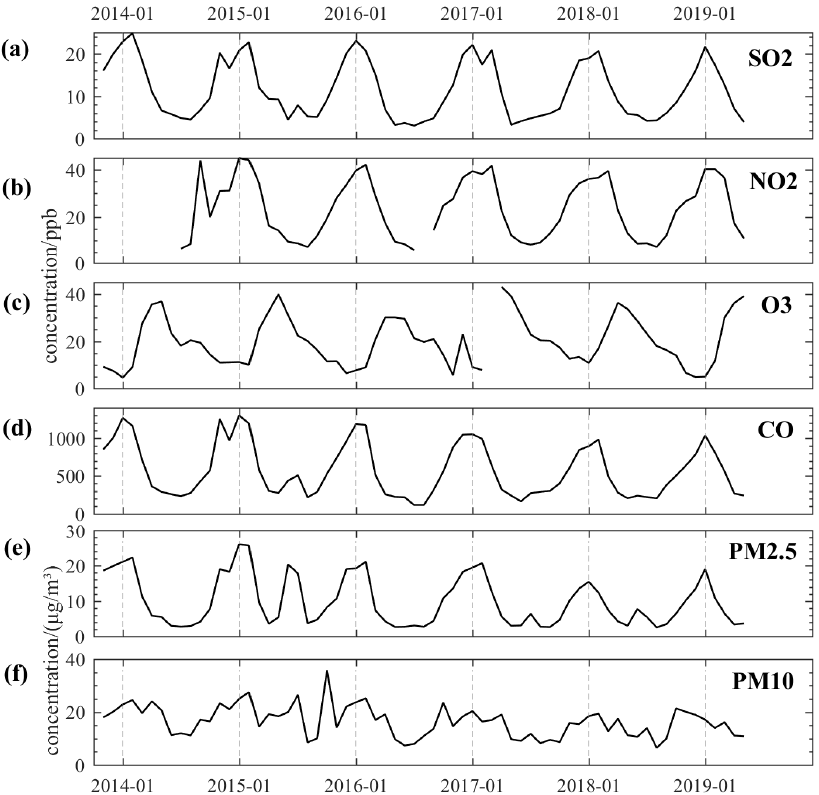
Figure 5. Monthly average concentration variations of ( a ) SO 2 ( b ) NO 2 ( c ) O 3 ( d ) CO ( e ) PM 2.5 ( f ) PM 10 from November 2013 to May 2019. Gray dashed lines represent January of each year.